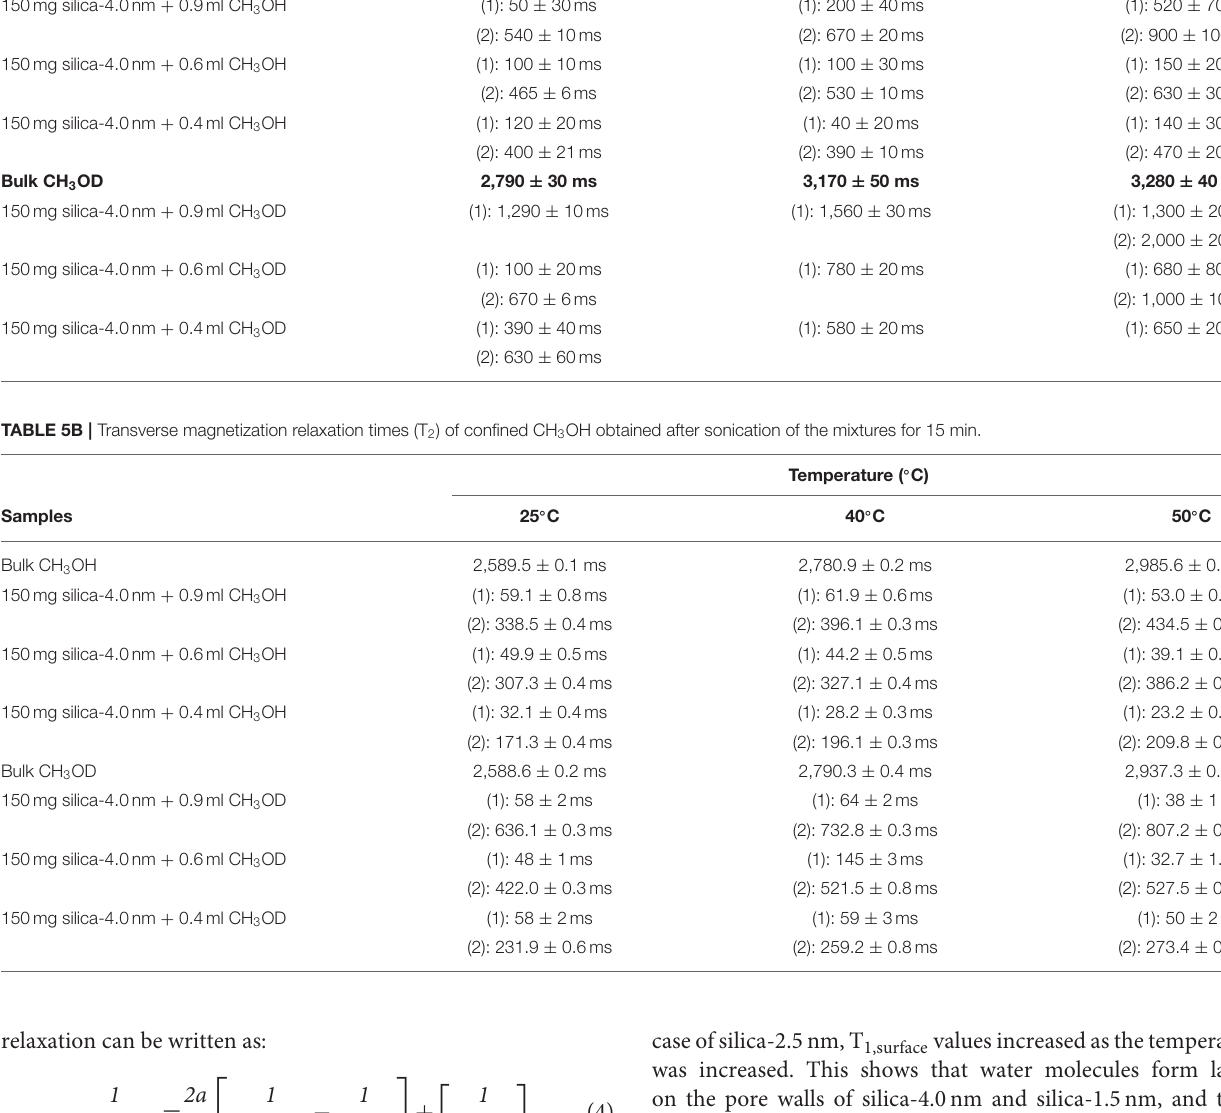
TABLE 5A | Longitudinal magnetization relaxation times (T 1 ) of confined CH 3 OH and CH 3 OD obtained after sonication of the mixtures for 15 min. Samples